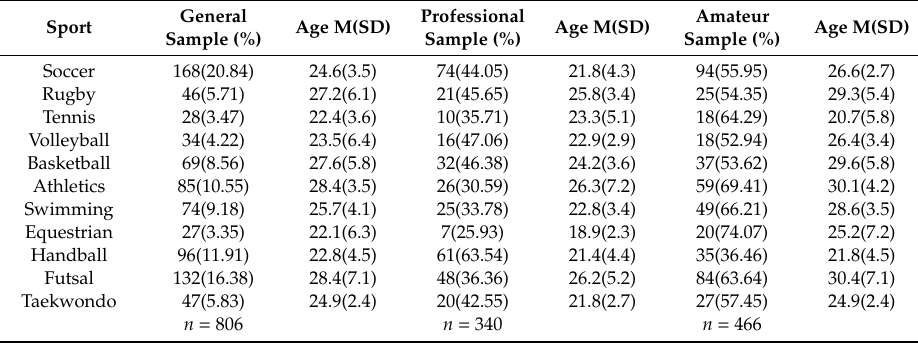
Table 1. Sample distribution for sport